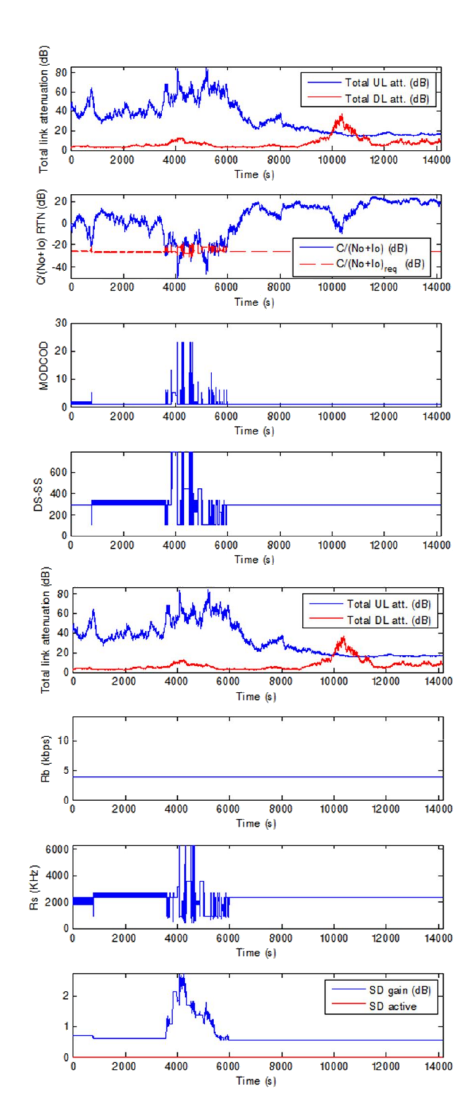
Figure 9. Adaptive strategy operation for UTD terminals in V